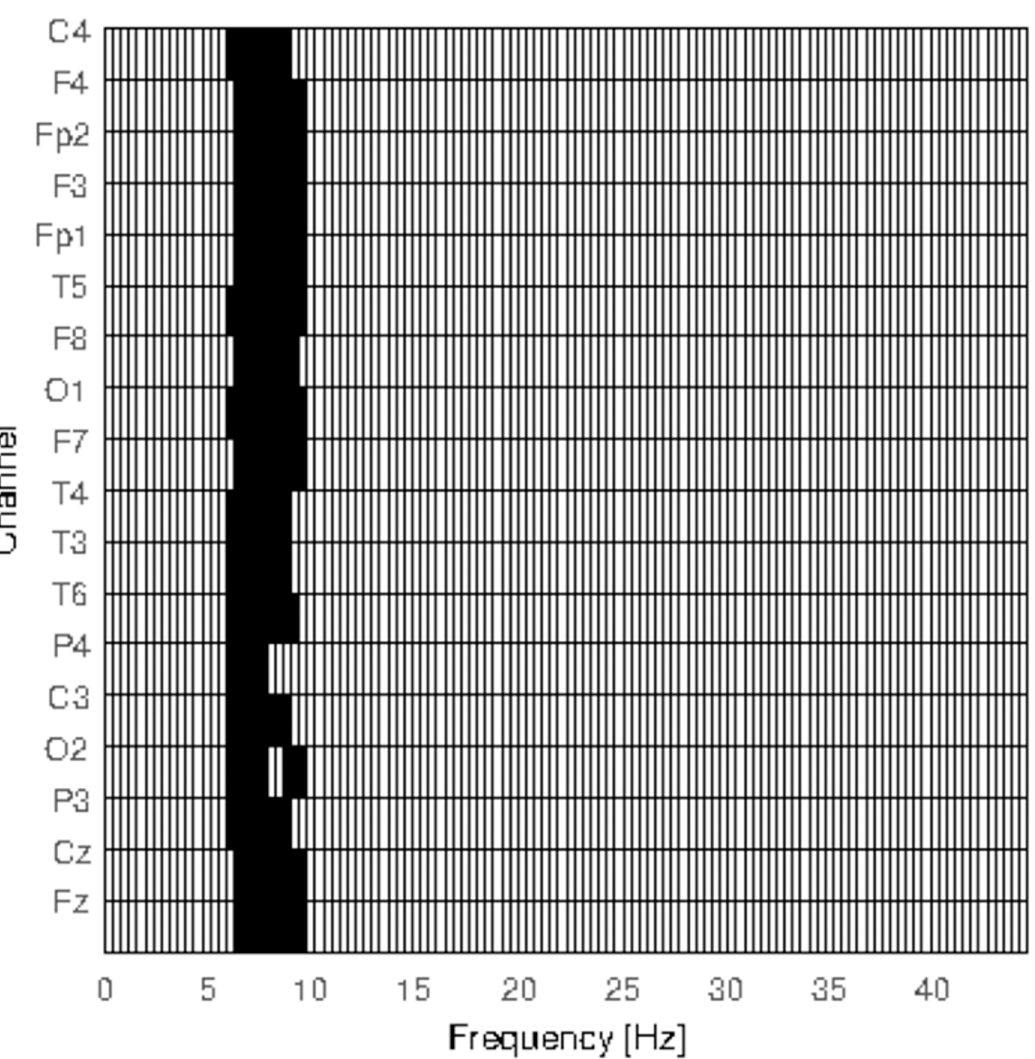
Fig 3. Clusters for the permutation test. Channeland frequency neighbors found by runningthe clusteringstage of the permutation test for the local spectral entropy.